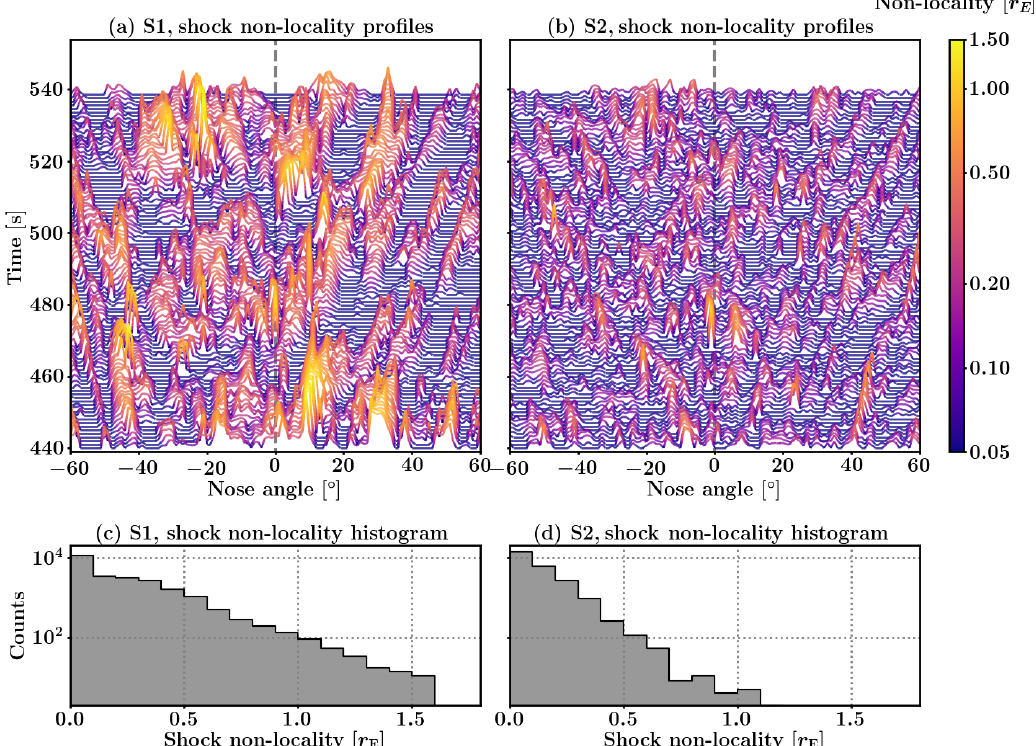
Figure 3. (a, b) Profiles of measured shock non-locality as a function of nose angle for simulations S1 and S2, respectively. The y axis indicates simulation time, used as the base level corresponding with a well-defined shock with a non-locality measure of 0. Regions of enhanced non-locality are shown as coloured peaks of the curve, as presented in the colour bar. A dashed vertical line indicates a nose angle of 0 ◦ . Both panels show chains of enhanced non-locality regions which move away from the nose region and decrease in intensity as they approach the flanks. Under each stacked profile plot we show a histogram depicting the occurrence rate of different non-locality values, with (c) depicting S1 and (d) depicting